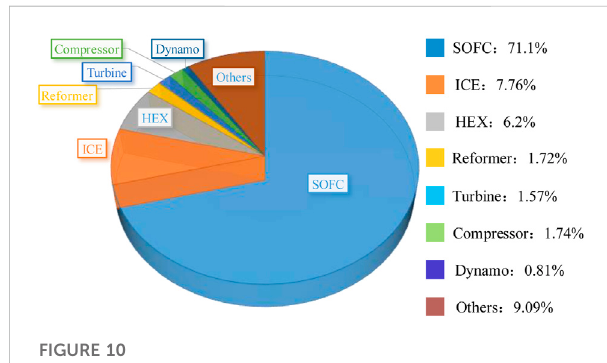
FIGURE 10 Mass of the devices in the ammonia SOFC/ICE